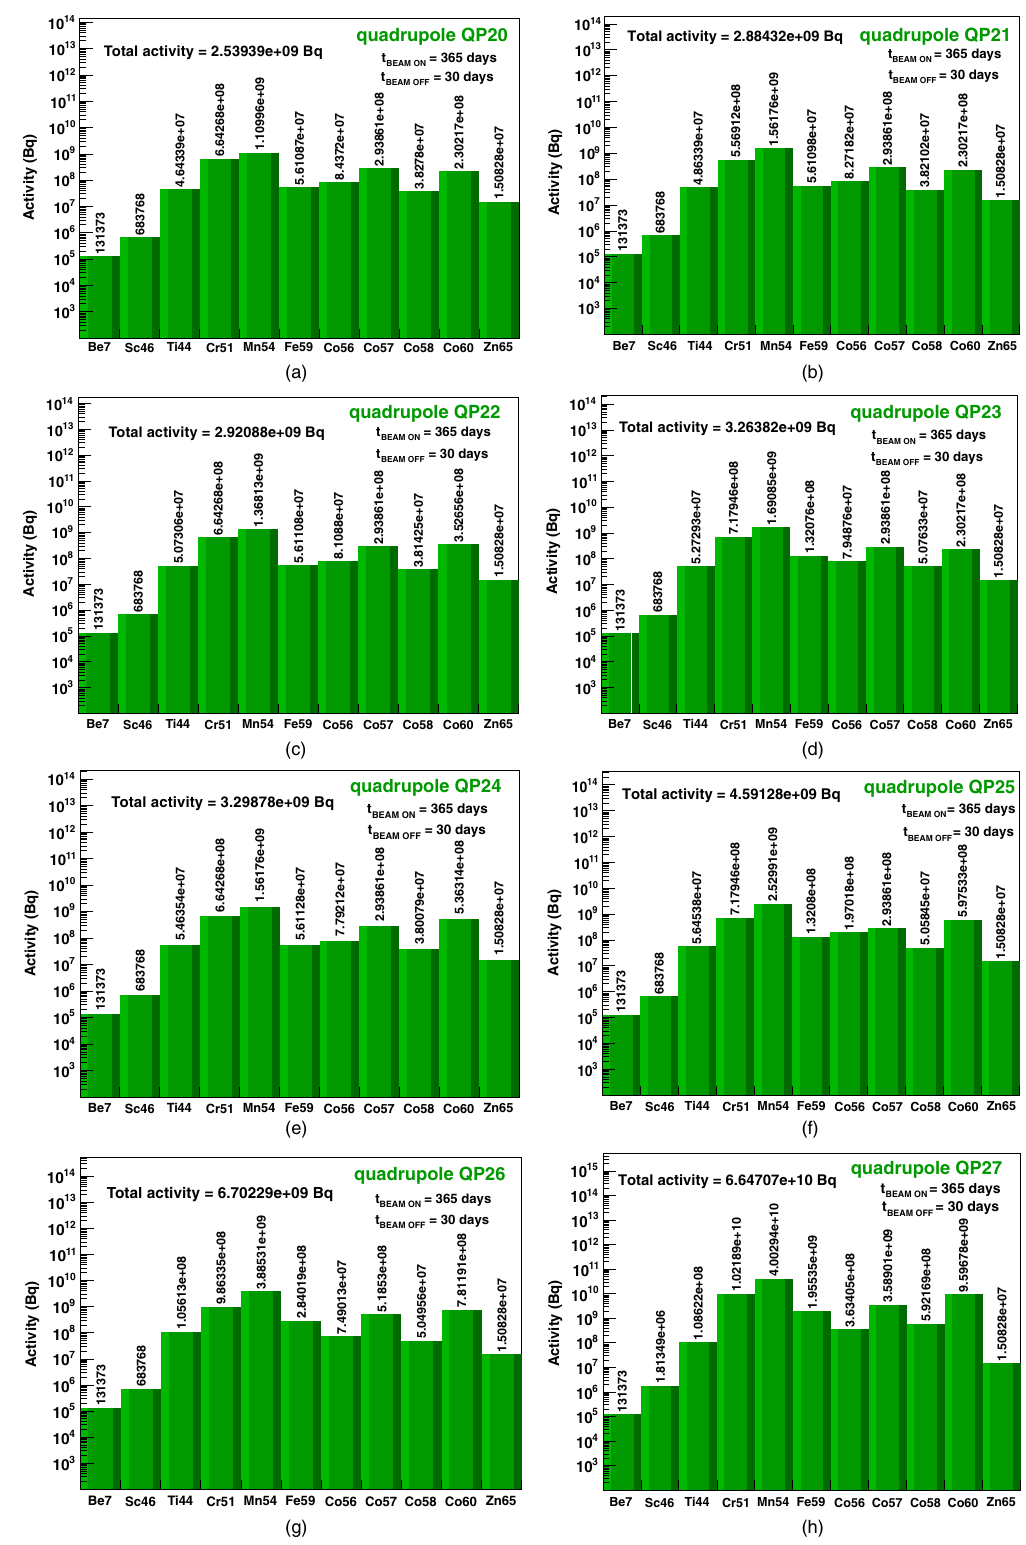
FIG. 9. Activity for the HEBT-S3 quadrupoles: (a) quadrupole QP20, (b) quadrupole QP21, (c) quadrupoles QP22, (d) quadrupole QP23, (e) quadrupoles QP24, (f) quadrupole QP25, (g) quadrupoles QP26, and (h) quadrupole